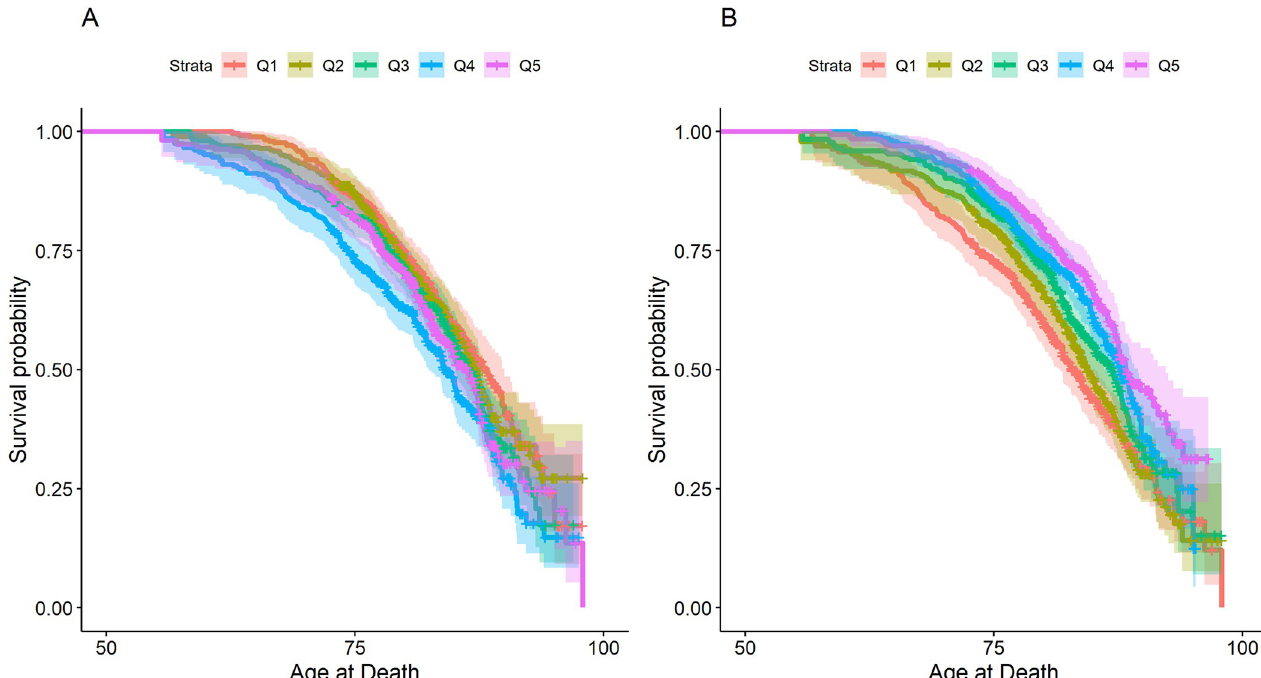
Fig 2. Survival curves for association between quintiles of African Ancestry (panel A) and nSES (panel B) with all-cause mortality among Self-Identified African American Participants in the Prostate, Lung, Colorectal, and Ovarian Cancer Screening Trial, United States, 1993–2019. Abbreviations: nSES, neighborhood Socioeconomic Status, Legend: Log-rank test p-values (Panel A: p = 0.043, Panel B: p < .0001).